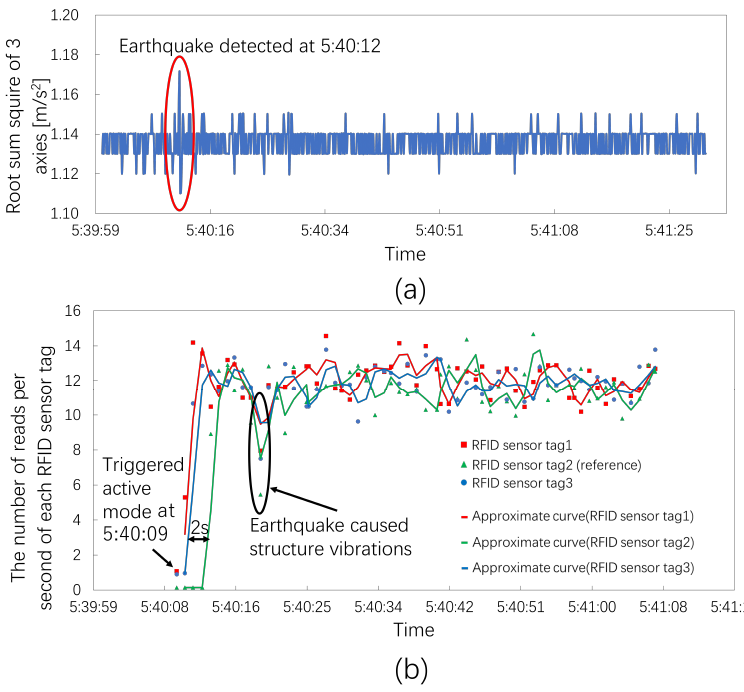
Figure 10. The number of reads per second for three RFID sensor tags at an earthquake seismic intensity of 2. ( a ) Root sum squares of the acceleration sensor system; the acceleration sensor system detected the earthquake at 5:40:12. ( b ) The number of reads per second of each RFID sensor tag; the RFID sensor tags triggered the active mode at 15:40:09.